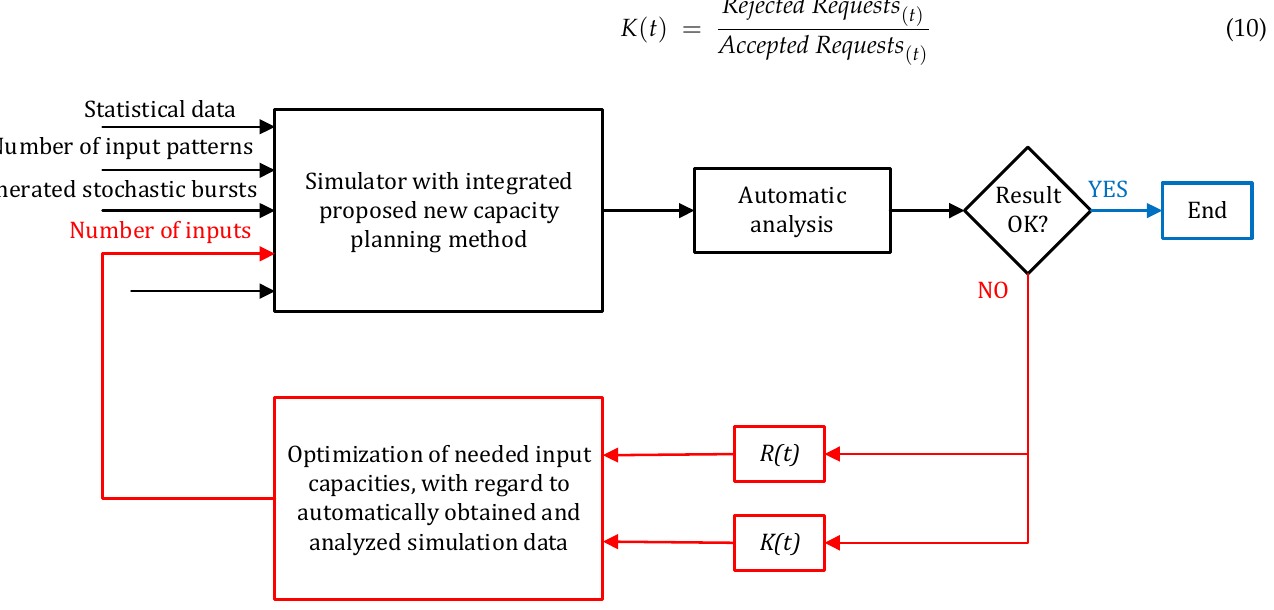
Figure 6. Considering functions R ( t ) and K ( t ), obtained with automatic analysis. Regarding time, K ( t ) is a curve on the lower side limited with 0 and practically unlim- ited upwards or limited with the relation between the maximum number of all users and the maximum number of available service capacities. The values and the meaning of the obtained curve K ( t ) are the following: 0 at a particular time index indicates that no input demand has been rejected (capacity is still available, but it is not fully utilized). Otherwise, factors K and R , and functions K ( t ) and R ( t ) are irrelevant and are not considered). In